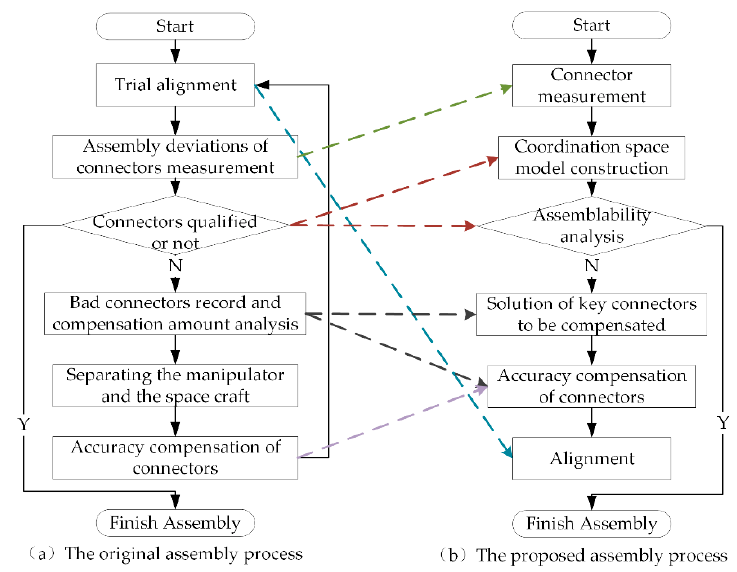
Figure 10. The comparison of the original and proposed assembly processes.